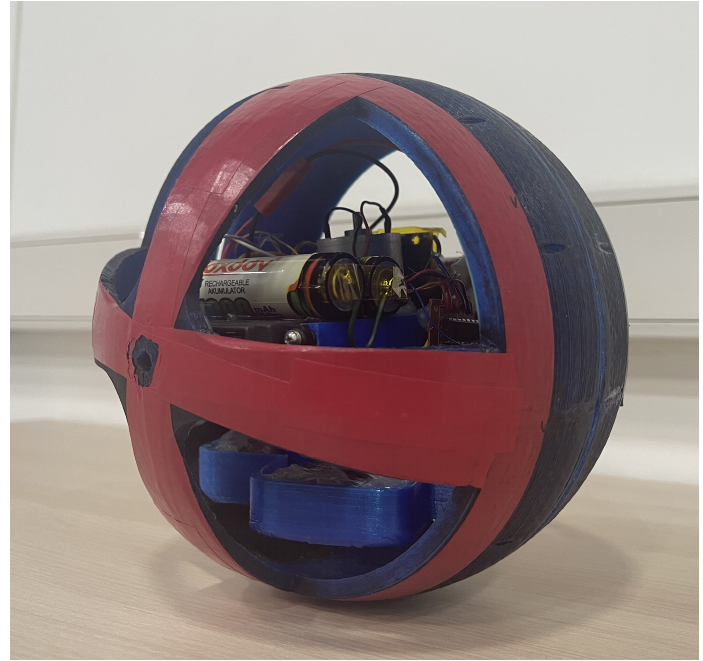
Figure 1. Actual spherical robot.